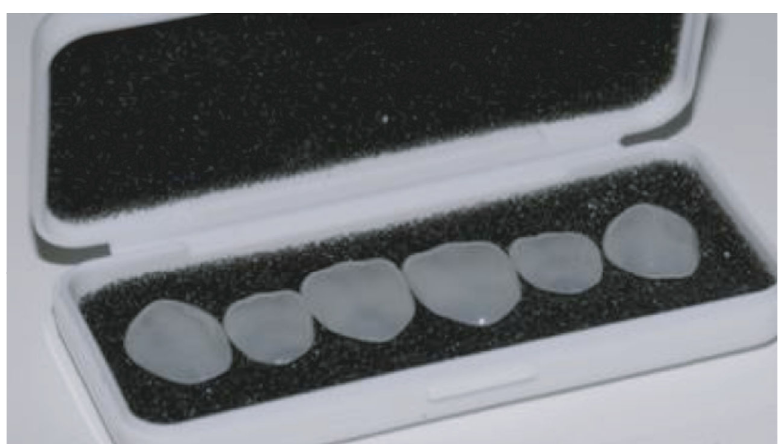
Figure 3: Edelweiss prefabricated composite veneers.